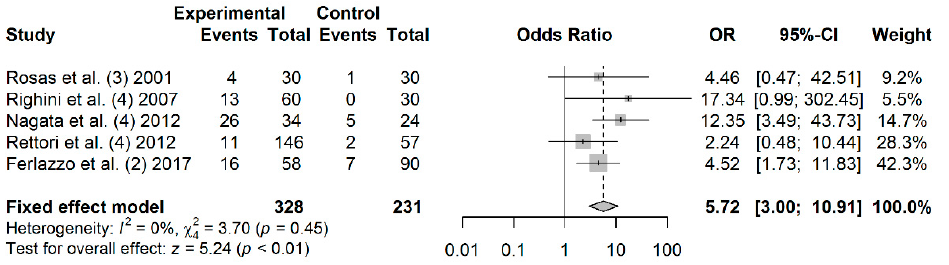
Figure 3. Forest plot for the association between MGMT promoter hypermethylation and HNC risk. The squares represent the ORs for individual studies. Bars represent the 95% CIs. The center of the diamond represents the summary effect size.